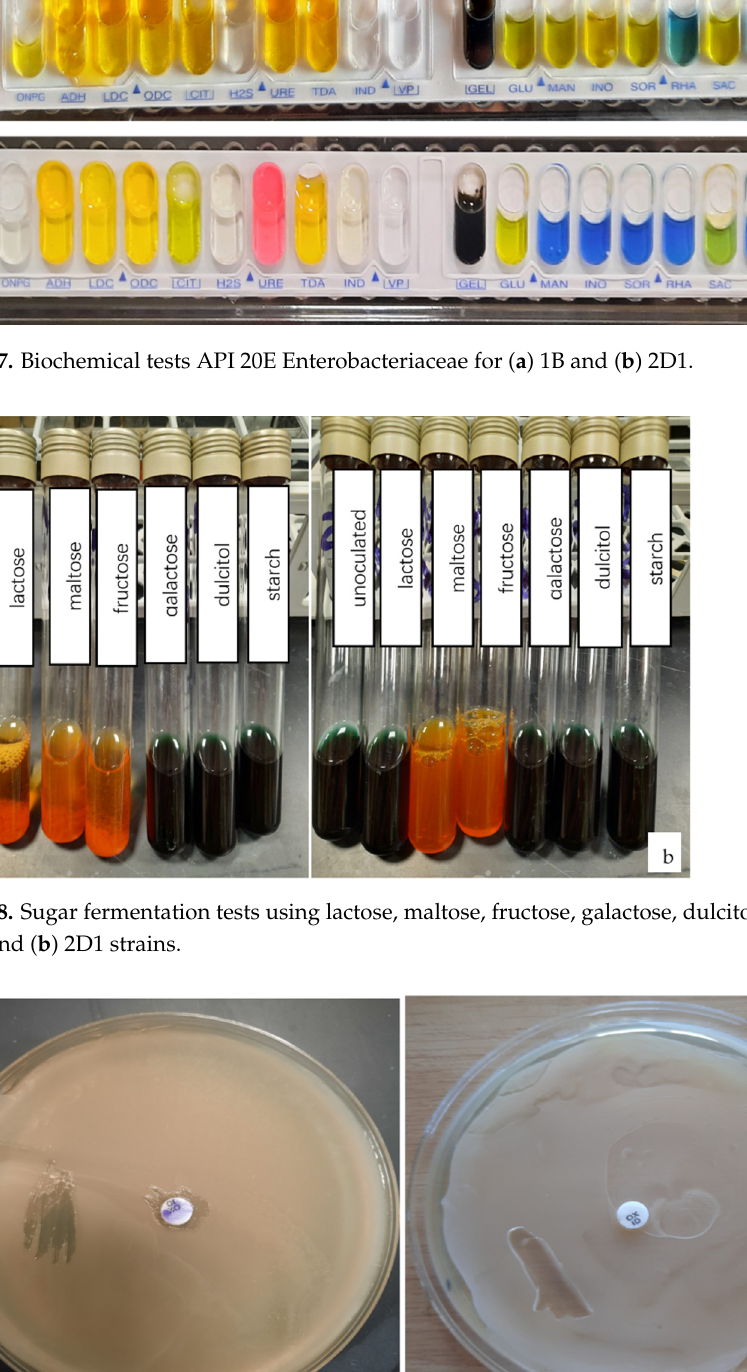
Figure 9. Sugar fermentation tests using lactose, maltose, fructose, galactose, dulcitol, and starch for ( a ) 1B and ( b ) 2D1 strains. Table 2. Provisional identification of the PHB producers 1B and 2D1.